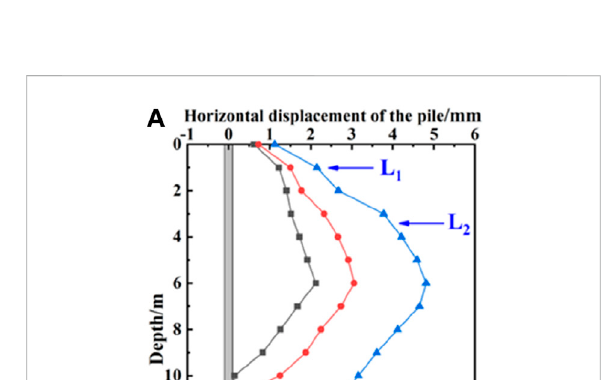
FIGURE 9 Layout of monitoring points.